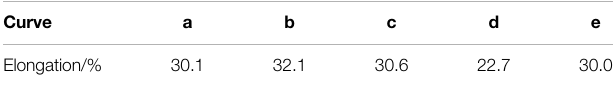
TABLE 5 | Elongation of Q235 steel with different treatments and tensile methods (a, b, c, d, and e correspond to Figure 5 ). Curve